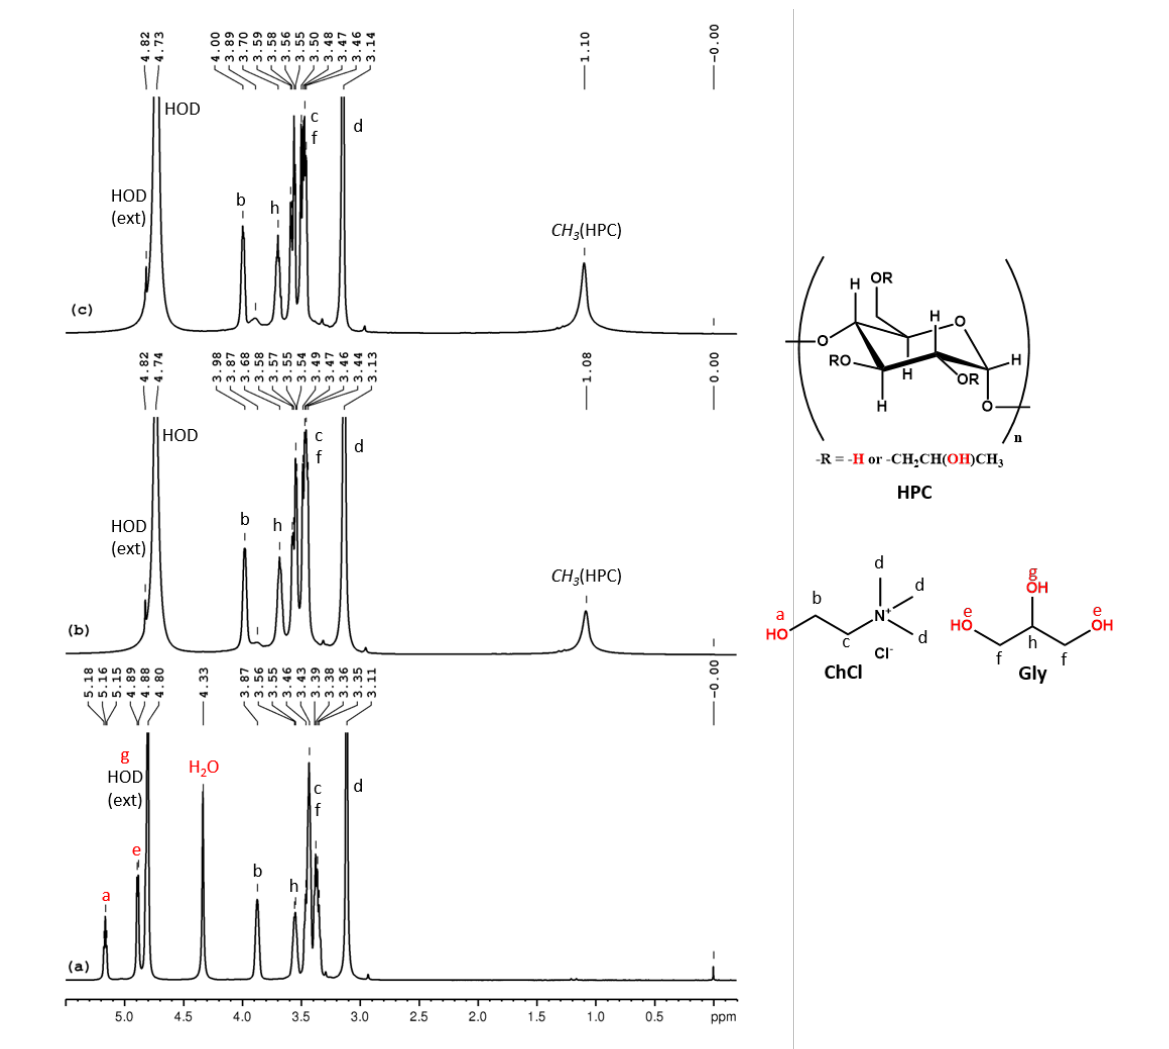
Figure 4. 1 H NMR spectra of ChCl-Gly ( a ), HPC-ChCl-Gly 29% ( b ) and HPC-ChCl-Gly 17% ( c ). In red color are marked the exchangeable protons.